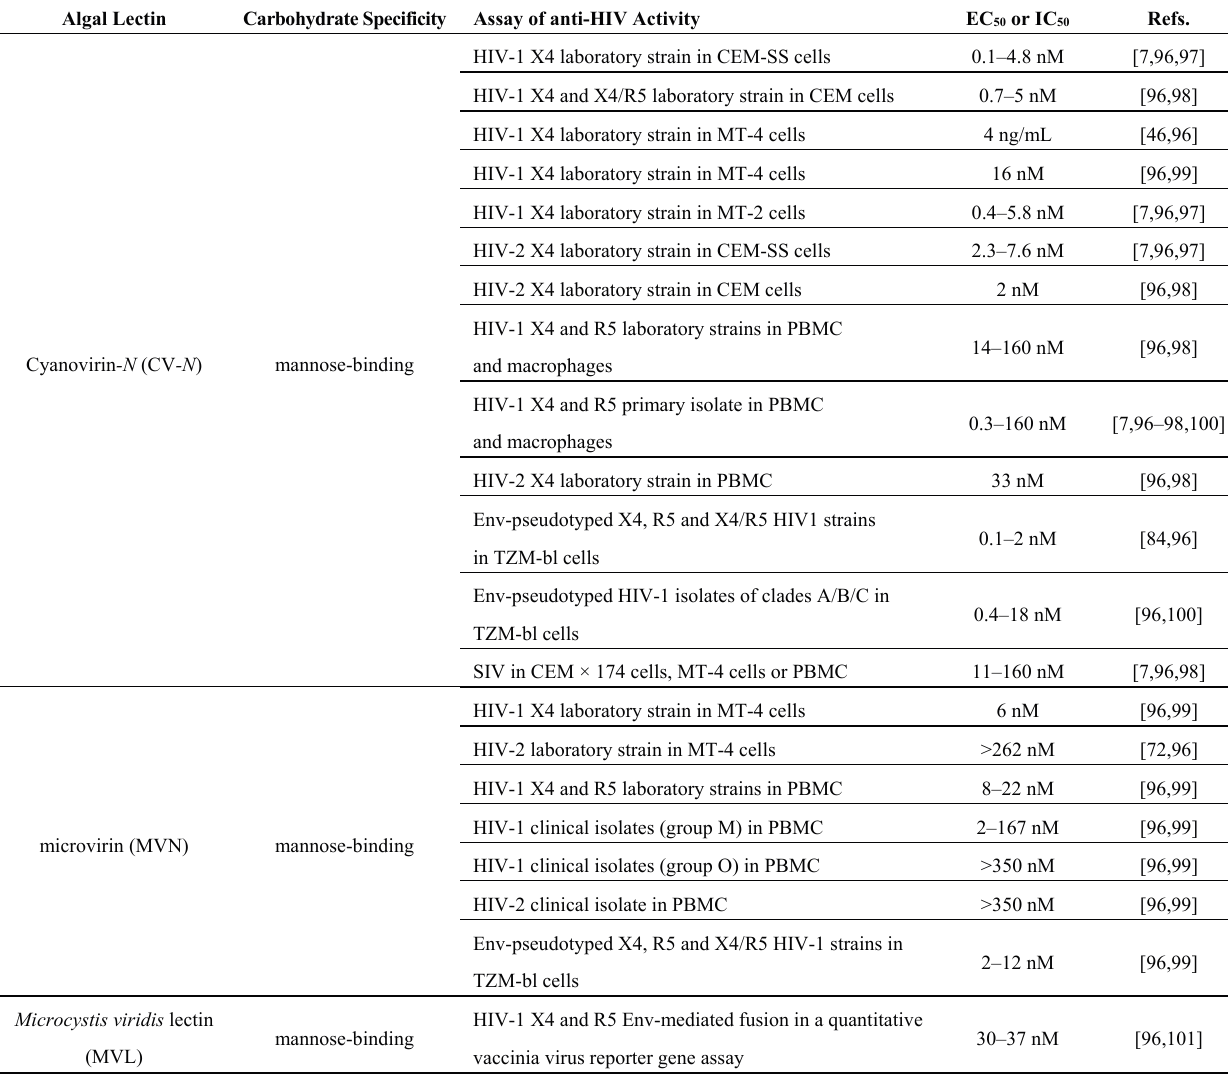
Table 1. Anti-HIV activity of algal lectins in different